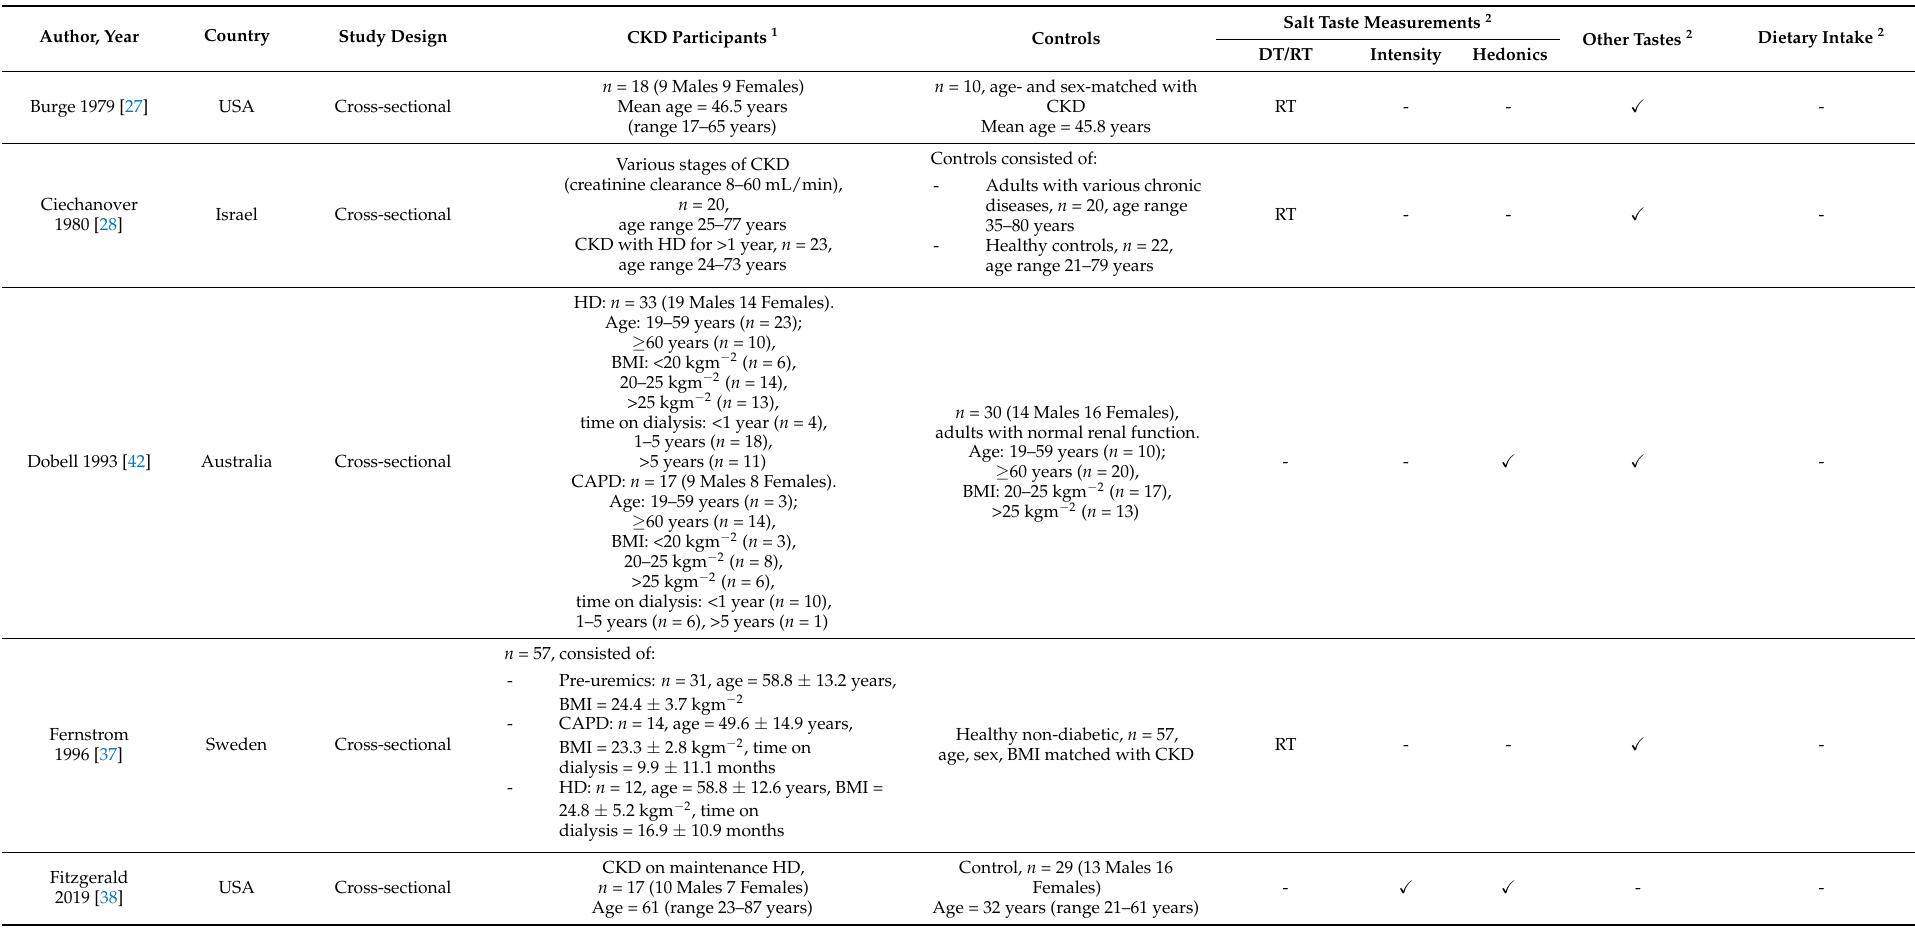
Table 2. An overview of the study design, participants’ characteristics, and measurements from the studies ( n = 16) included in this systematic